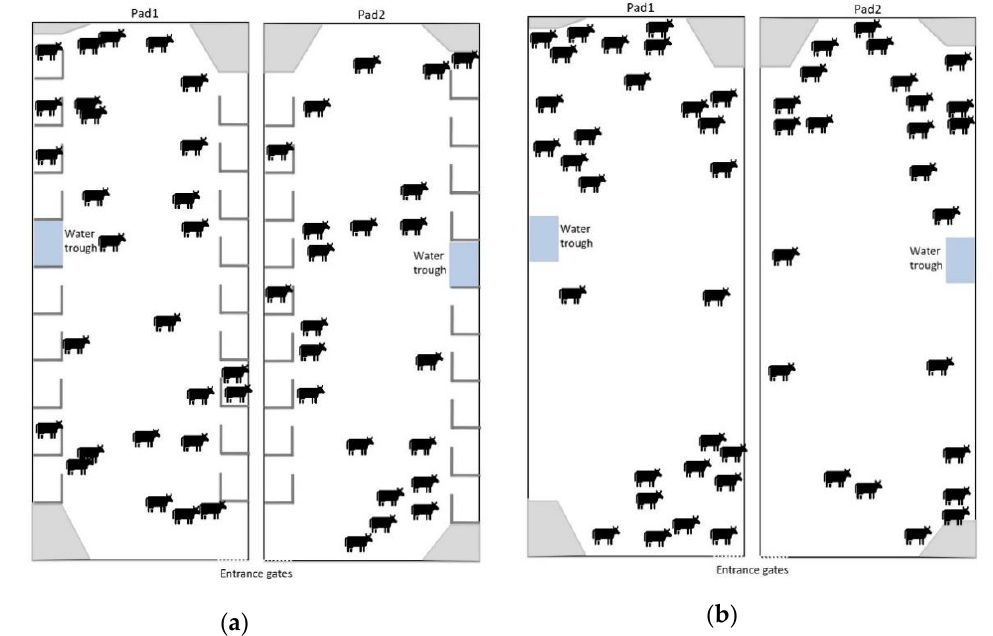
Figure 4. Plots of calving location during Phase 1: ( a ) When hides were open ( n = 49); ( b ) When hides were closed ( n = 52). Stocking density was standardized at 50 cows / pad, bedding was cleaned daily and cows were randomly allocated to calving pads each night. Hides were opened and closed on alternating nights on each pad. Cows were on pasture together during the day.